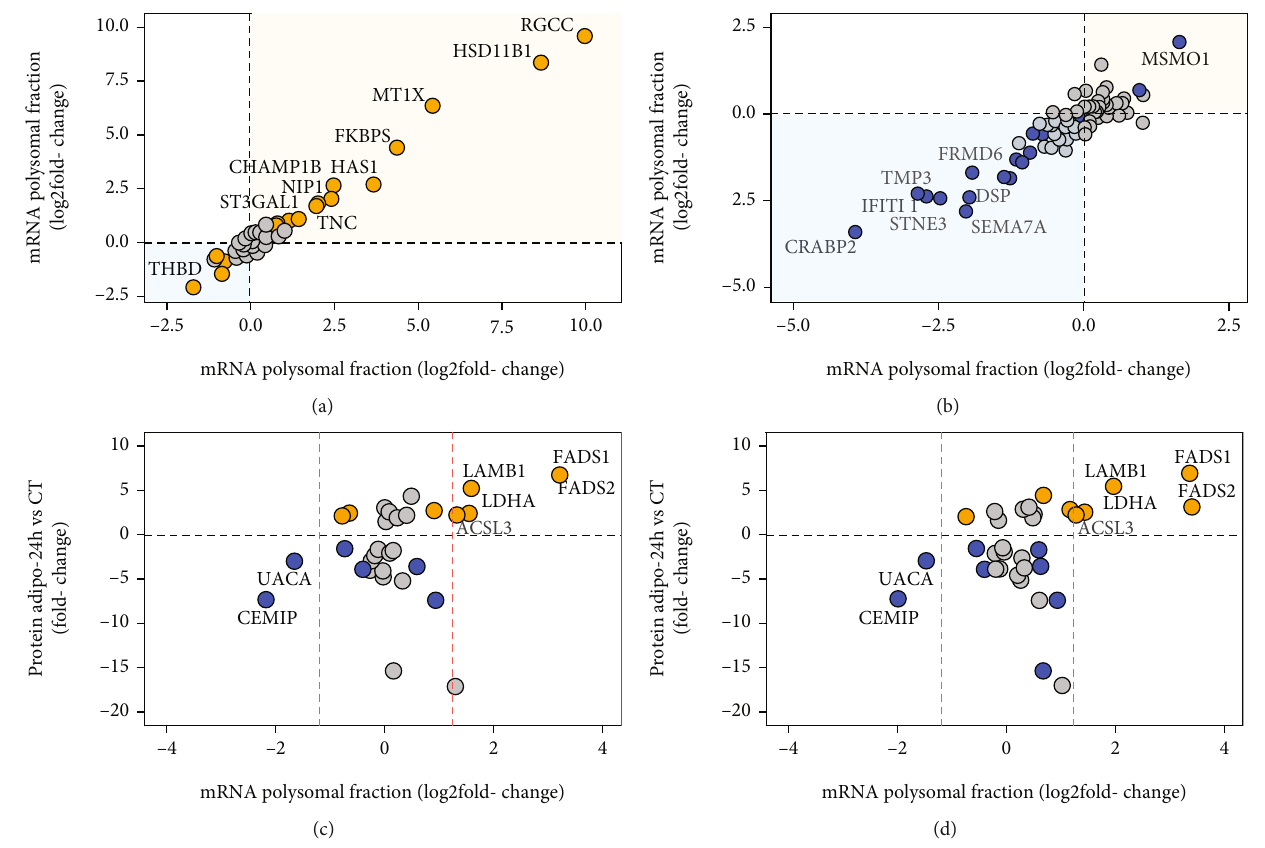
Figure 5: Gene expression regulation during the fi rst step of human adipogenesis. (a) Scatterplot comparing RNA-seq from the total and polysomal fractions of hASC submitted to adipogenesis (24 hours), showing 53 proteins uniquely identi fi ed in 24h-di ff erentiated cells. (b) The same analysis with the 92 proteins uniquely identi fi ed in undi ff erentiated hASC. Orange and blue dots represent genes with FDR ≤ 5 % . The named dots represent DEGs in the total and polysomal fractions. Orange and blue boxes represent adipogenesis (24 hours) and undi ff erentiated hASC, respectively. The di ff erentially abundant proteins (up- and downregulated) were compared with the mRNA expression of the (c) total and (d) polysomal fraction. Orange and blue dots represent genes with FDR ≤ 5 % in the ADI and CT conditions, respectively. Dashed red lines represent the cuto ff criteria for fold change in the RNA-seq